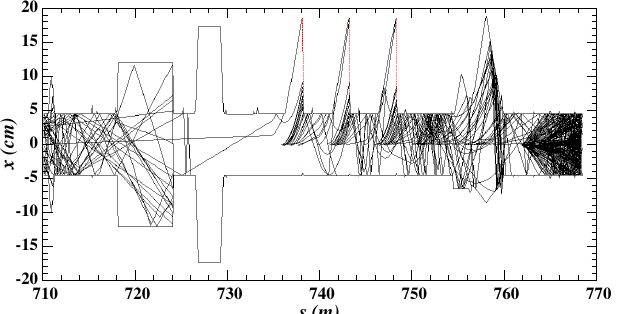
FIG. 4. Modeled photon trajectories in a section of the CESR ring which includes various vacuum system components as well as x-ray beam exit ports. Projections of the horizontal position x of the photons relative to the positron reference orbit are shown. The positrons travel in the direction of increasing s coordinate. The red vertical lines represent the exit port windows; any photon hitting those surfaces is terminated and excluded from the absorbed-photon rate.